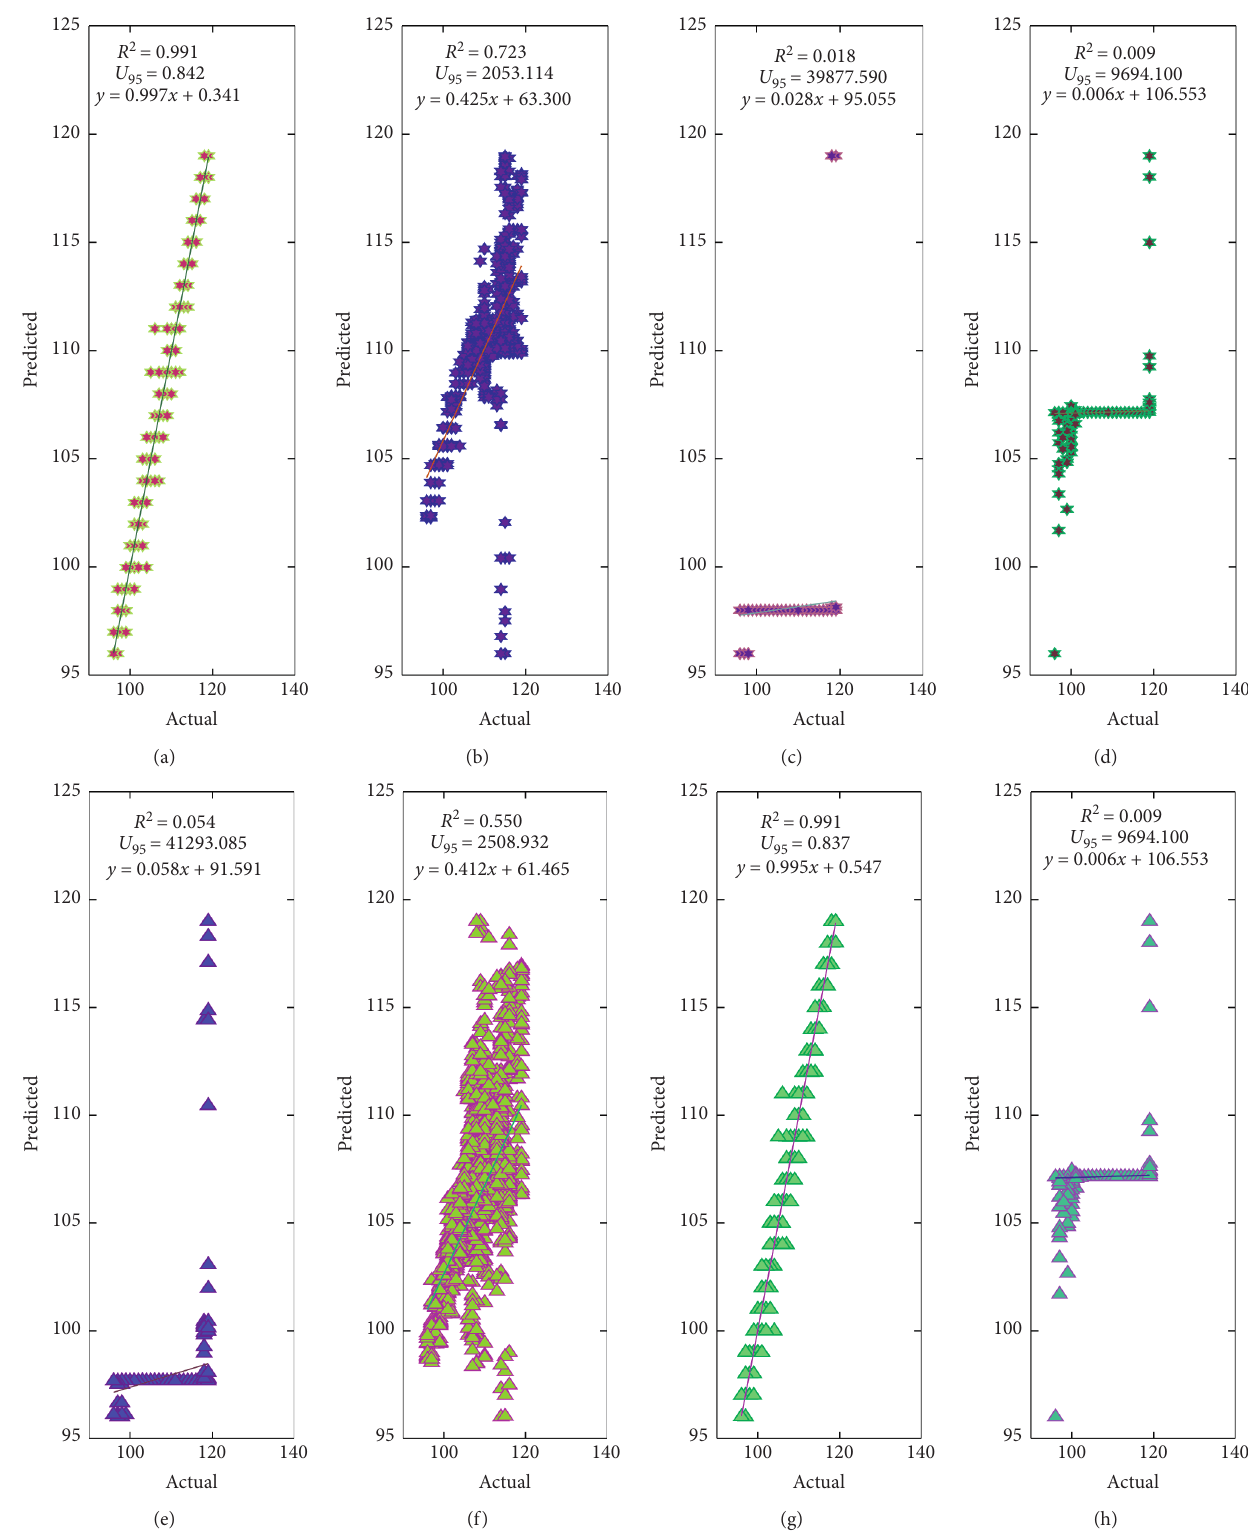
Figure 11: SVR models for USGS 14150000 station: coefficient of determination. (a) SVR-M1. (b) SVR-M2. (c) SVR-M3. (d) SVR-M4. (e) SVR-M5. (f) SVR-M6. (g) SVR-M7. (h)